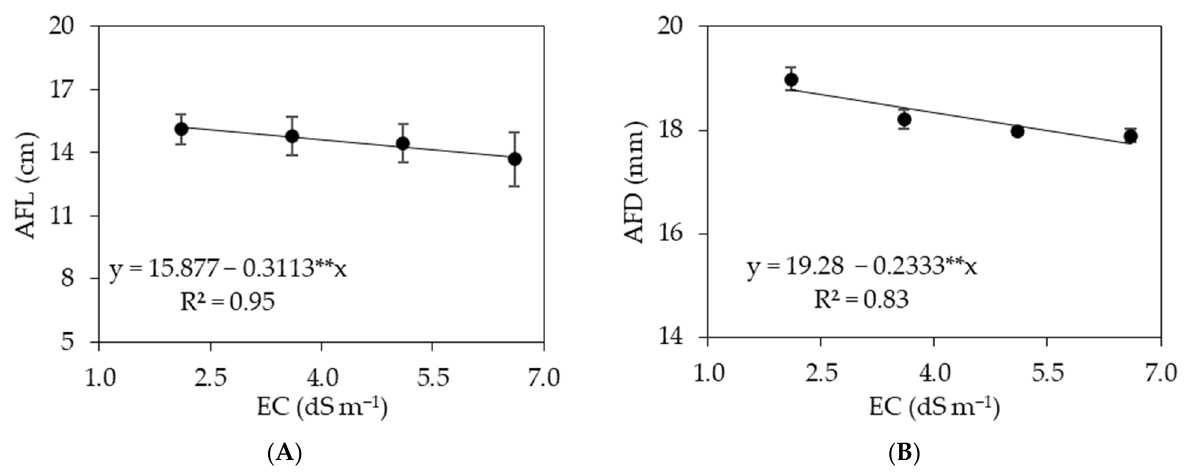
Figure 8. Average fruit length ( A ) and average fruit diameter ( B ) of ‘Canindé’ okra cultivated in a hydroponic system as a function of the electrical conductivity of the nutrient solution (EC) in harvest performed in the period from 81 to 91 days after transplanting. ** significant at p ≤ 0.01. The vertical lines represent mean +/ − standard error (n = 4).